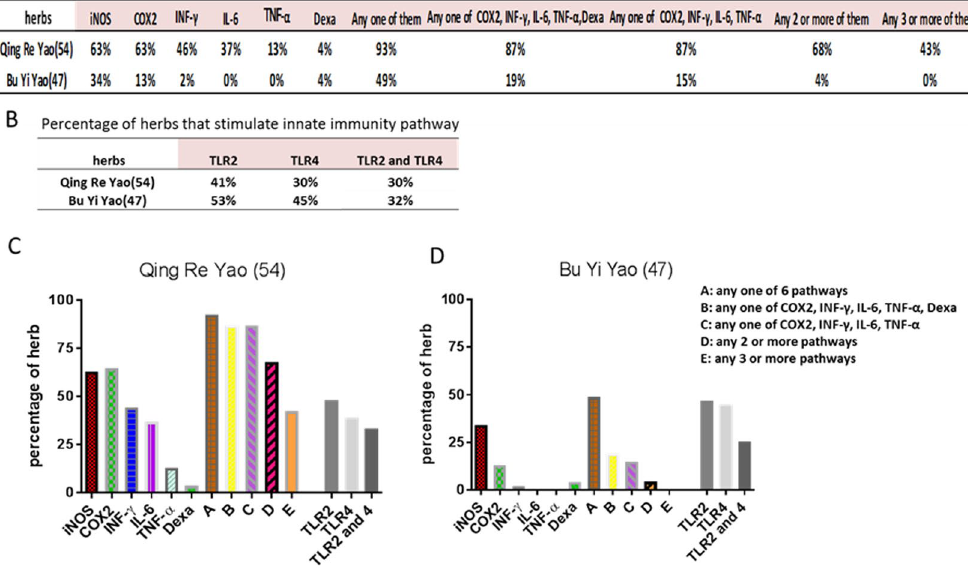
Figure 2. Anti-inflammatory action and stimulation of innate immunity of two categories of Chinese herb medicine. ( A ) Percentage of “Qing Re Yao” and “Bu Yi Yao” in affecting on the inflammatory cytokine or glucocorticoid signaling pathway and COX2, iNOS enzyme activity. ( B ) Percentage of “Qing Re Yao” and “Bu Yi Yao” in affecting on innate immunity pathway. ( C ) Percentage of “Qing Re Yao” in affecting on inflammatory processes and innate immunity pathways. ( D ) Percentage of “Bu Yi Yao” in affecting on inflammatory processes and innate immunity pathways. Inhibition was cut defined as more than 50% inhibition; stimulation was defined more than 3 times stimulated at concentration of herbs under 750 µ g/ml in luciferase reporter signaling assay or under 4 mg/ml in enzyme